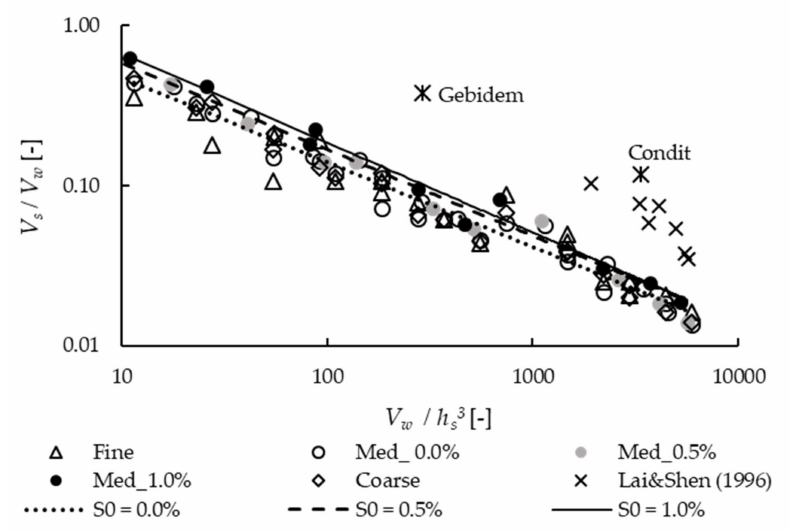
Figure 6. Evolution of V s /V w for varying values of V w /h s3 , S 0 , and D * .